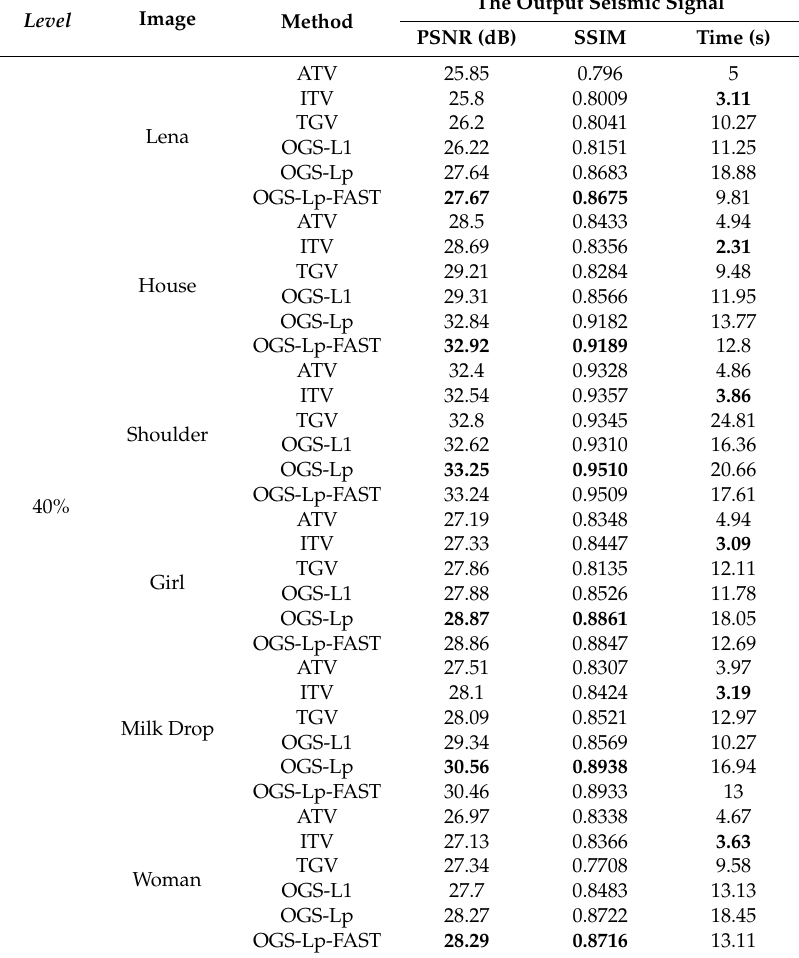
Table 4. Numerical comparison of our proposed method and other models (images are corrupted by impulse noise of